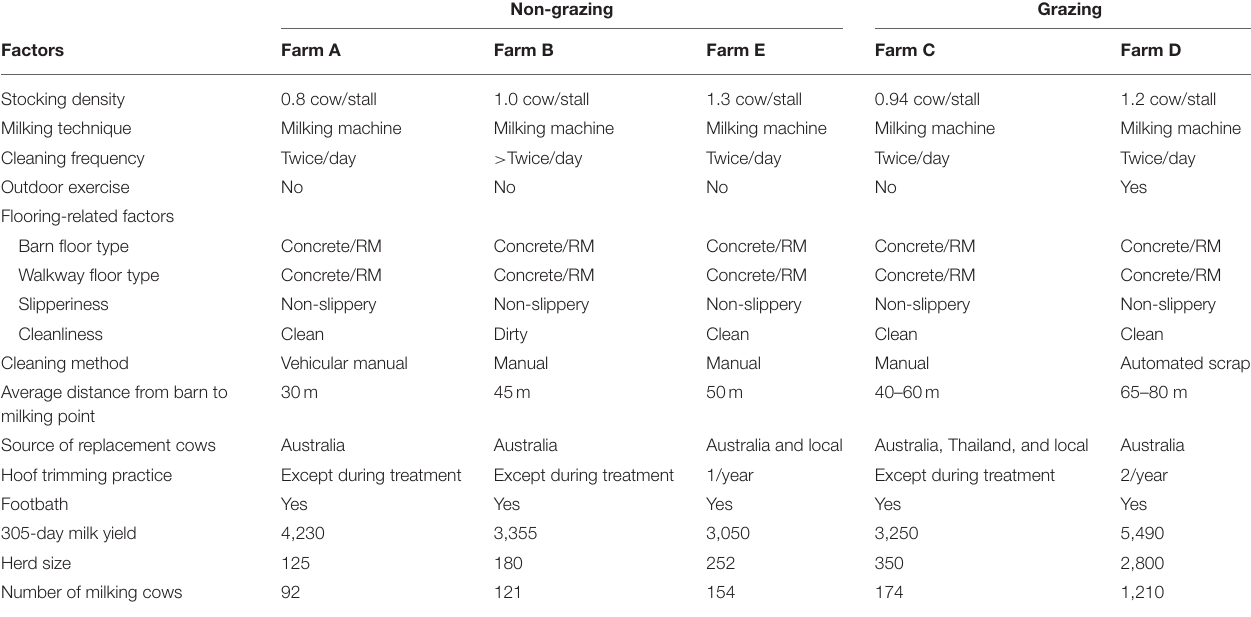
TABLE 1 | Herd level factors of the non-grazing ( n = 3) and grazing ( n = 2) farms enrolled in the